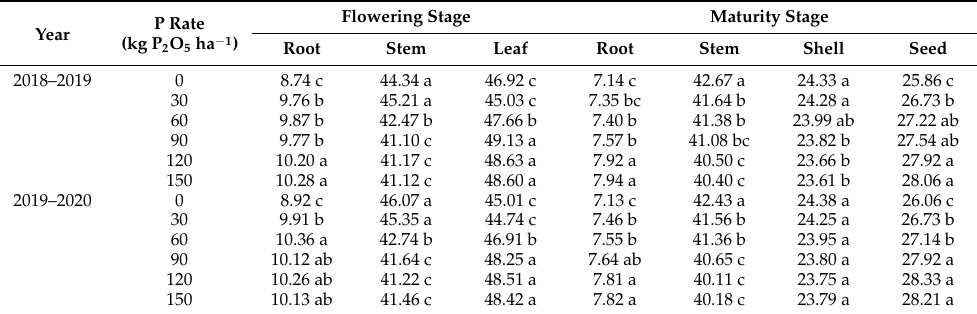
Different letters indicate significant difference at p = 0.05 between P rate treatments during the same growing season.